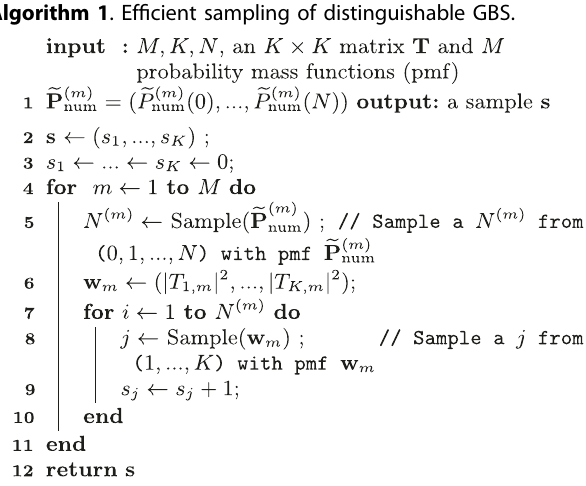
Algorithm 1 . Ef fi cient sampling of distinguishable